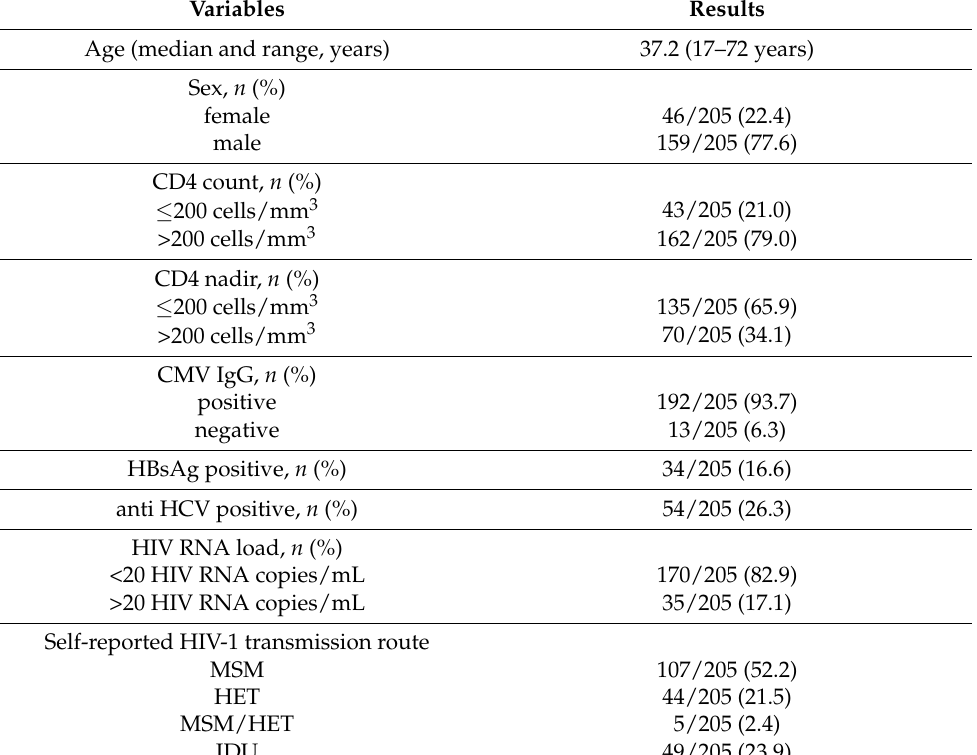
Table 1. Demographic, clinical, and virological characteristics of the HIV/CMV co-infected adult patients ( n =